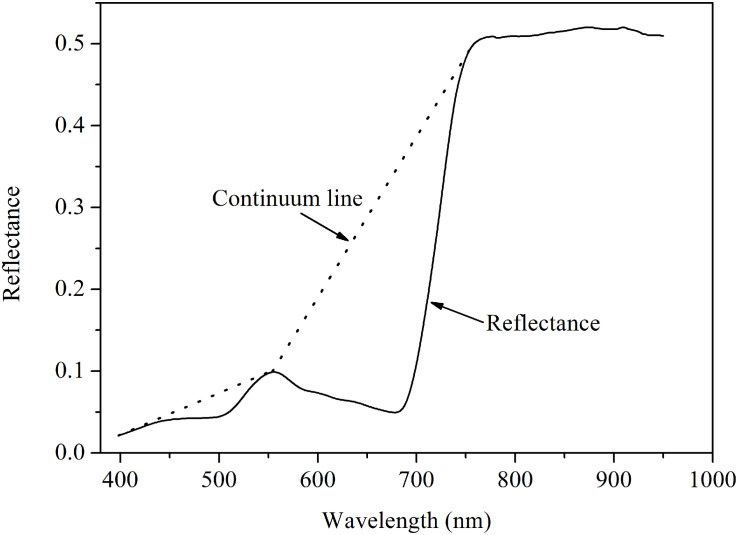
Schematic diagram of the continuum removal technique on the winter wheat canopy.